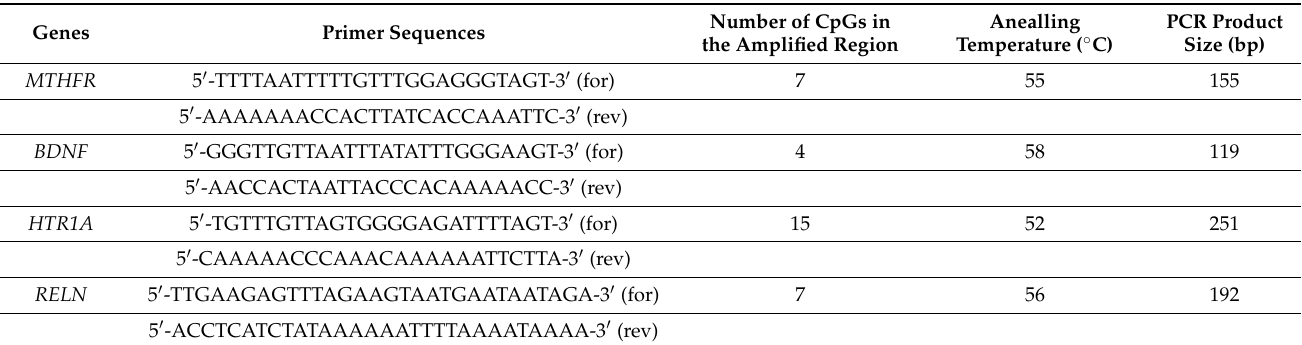
Table 1. PCR conditions, location of CpGs and dinucleotides, and primer sequences for PCR amplifica-